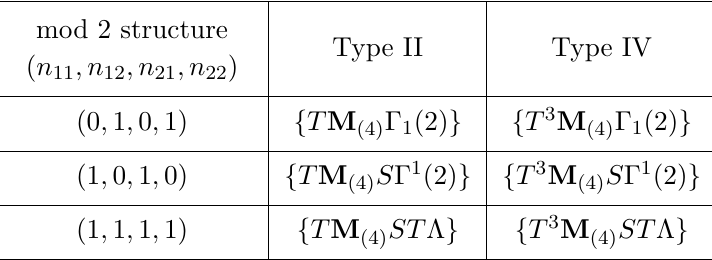
Table 12 . Classification of Types II and IV for D = 4